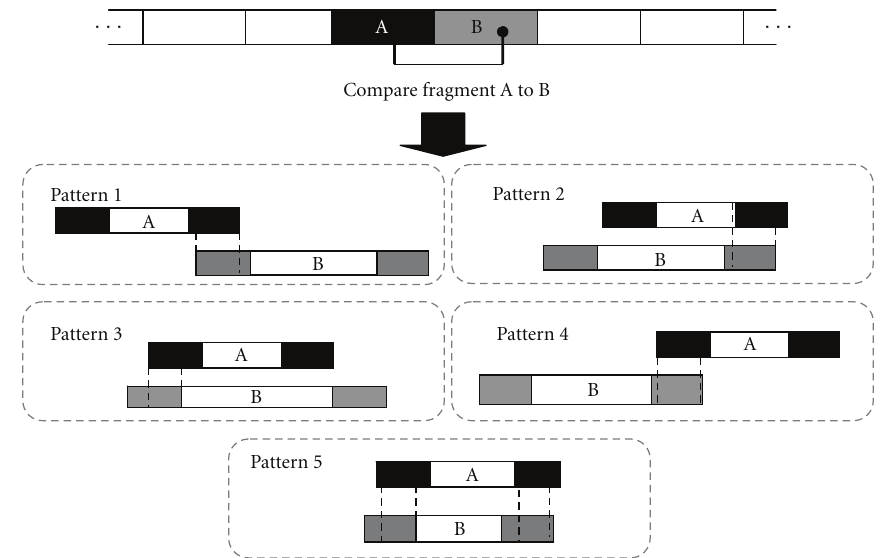
Figure 5: Matching pattern of two fragments. Pattern 1: tail-part of fragment A overlaps with the beginning of fragment B. Pattern 2: tail- parts of the two fragments overlap. Pattern 3: beginning of the two fragments overlap. Pattern 4: beginning of fragment A overlaps with end of fragment B. Pattern 5: both beginning and end of the two fragments overlap.